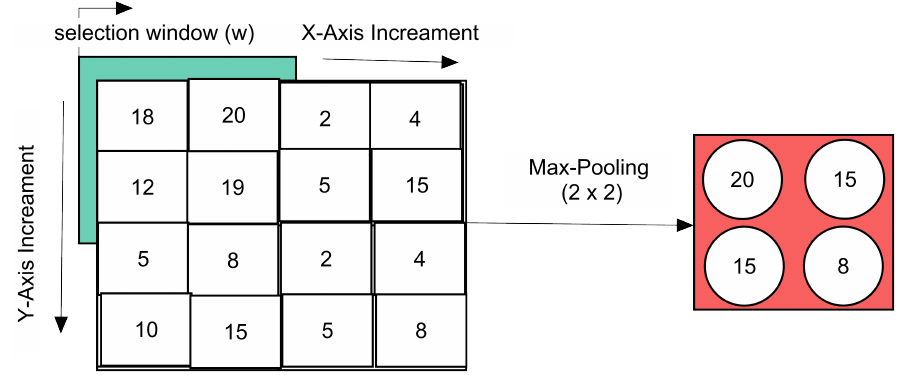
Figure 3. Max-pooling operation employed for proposed CNN.